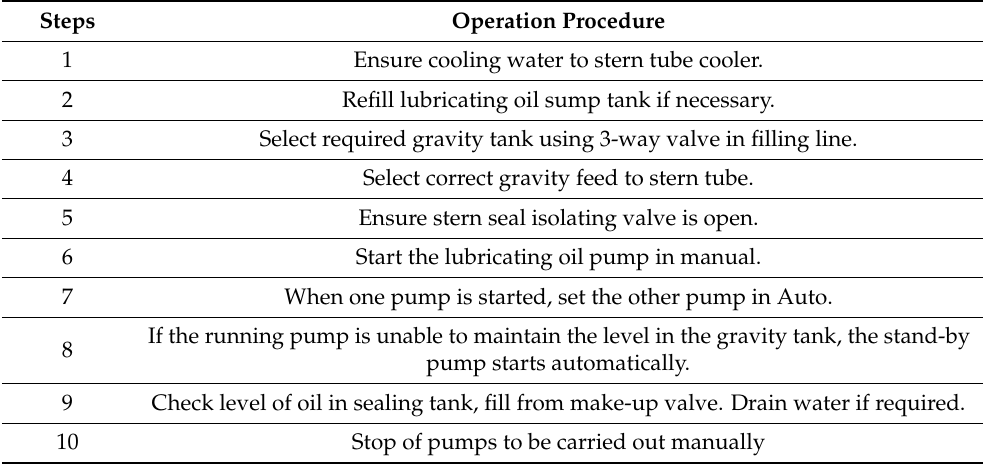
Table 3. Stern tube system operation